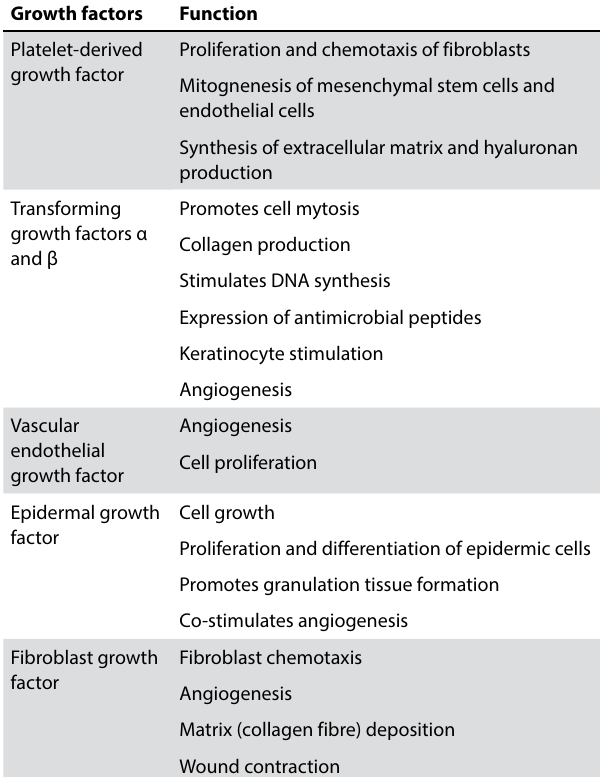
Table 1 : Growth factors released by platelets Growth factors Function Platelet-derived Proliferation and chemotaxis of growth factor